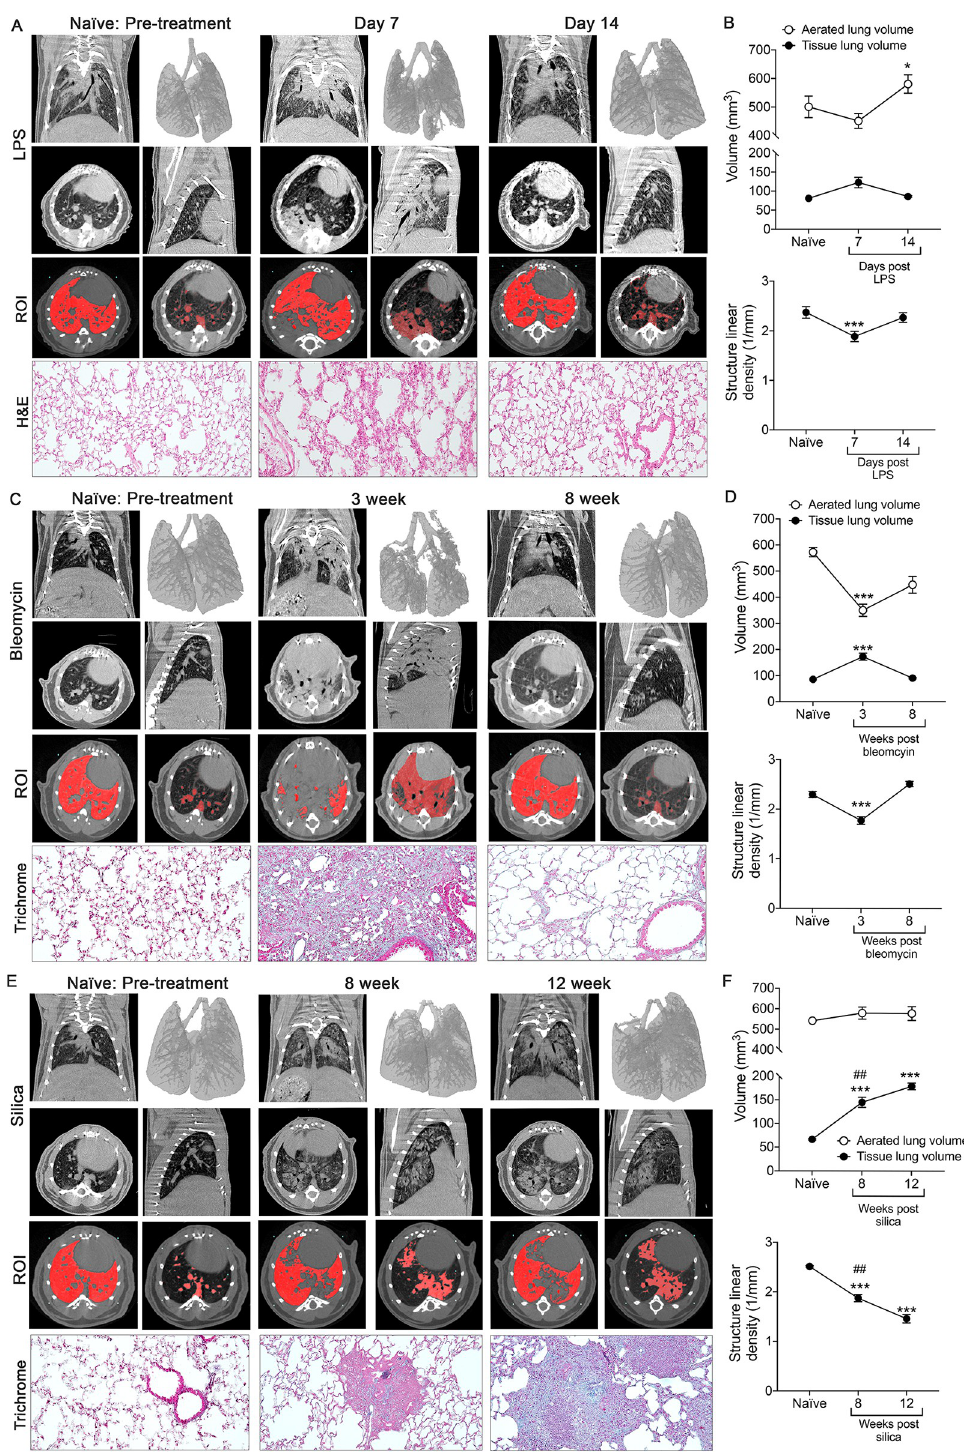
Fig 3. Longitudinal Imaging during the development, resolution and progression of lung disease. For longitudinal studies, mice were scanned on a Bruker Skyscan 1276 at 35 μ m resolution. (A) Representative image of na ï ve mice scanned prior to instillation with LPS (left panels, pre-treatment), 7 days post-instillation (middle panels), and 14 days post-instillation (right panels). Images include coronal (top left), transverse (middle left), and sagittal (middle right) slices and a 3D surface rendering of aerated (gray) and tissue (blue) volume overlay (top right). PATS generated ROI for